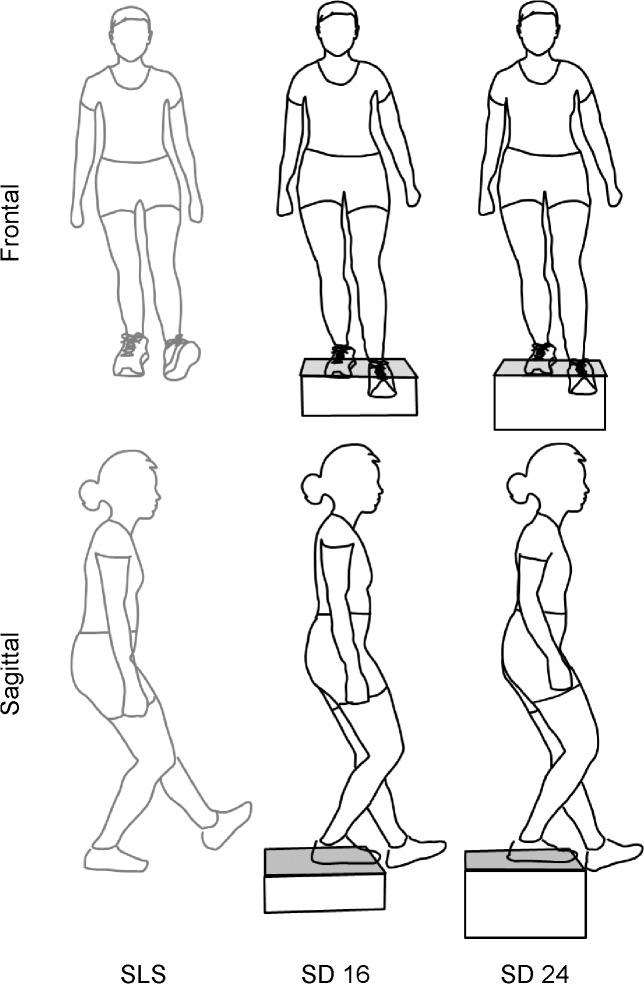
Pictorial representation of a participant performing the single leg squat task (SLS) and step down task from a 16 cm height (SD16) and from a 24 cm height (SD24) at 60° of knee flexion.